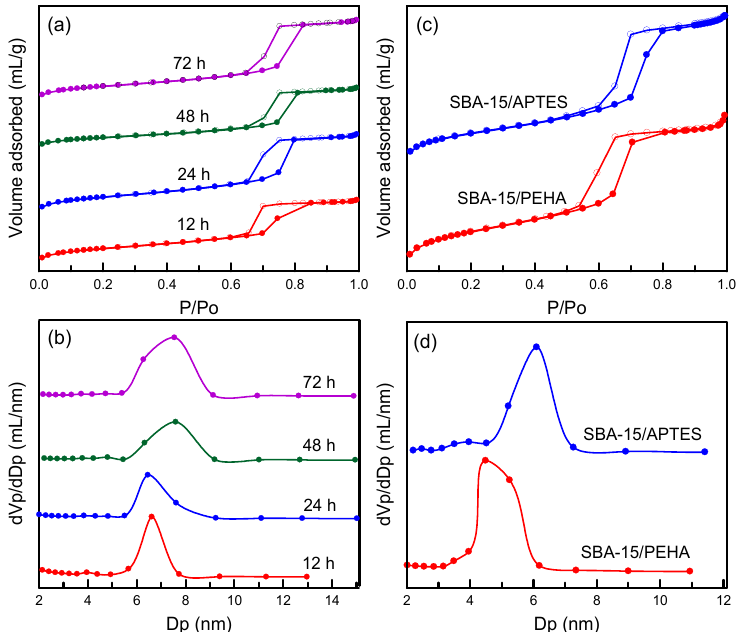
Figure 5. Nitrogen sorption isotherms and pore size distributions: ( a , b ) SBA ‐ 15 samples at different hydrothermal treatment times; ( c , d ) SBA ‐ 15/APTES and SBA ‐ 15/PEHA samples. Table 1. Surface area, pore volume, and pore diameter of silica specimens.